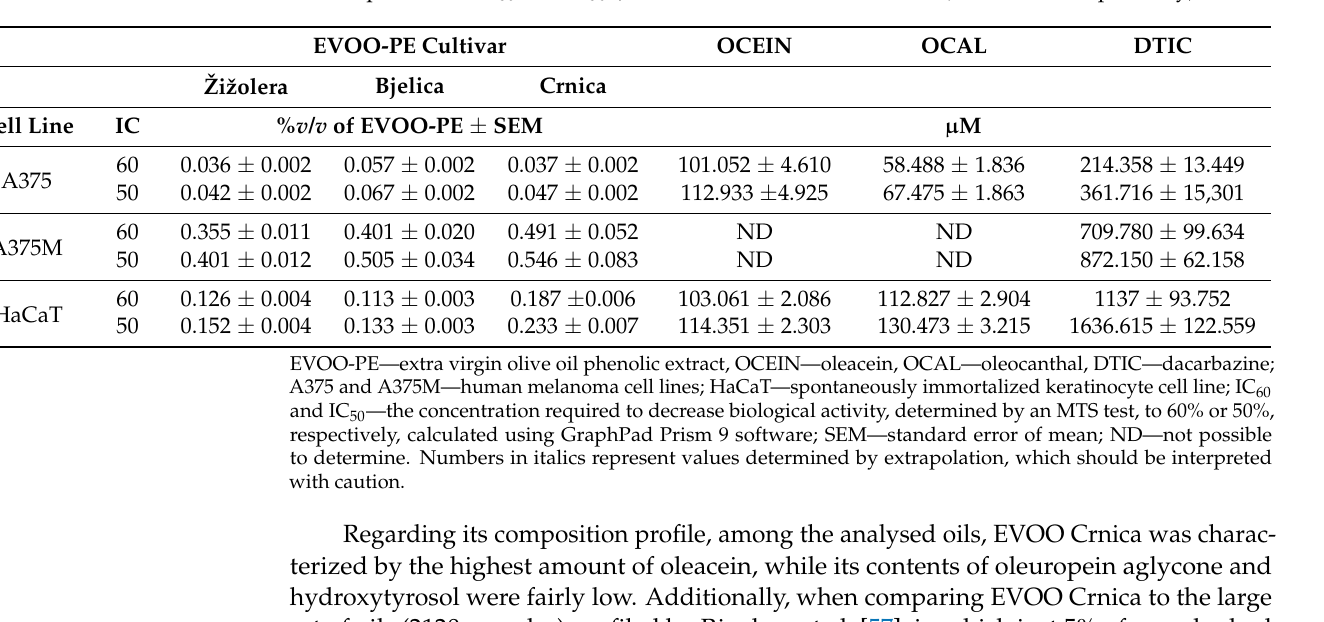
Table 3. Biological activity of EVOO-PEs, OCEIN, OCAL, and DTIC in A375, A375M, and HaCaT cells, expressed as IC 60 and IC 50 (in % v / v of EVOO-PE ± SEM or µM ± SEM, respectively).